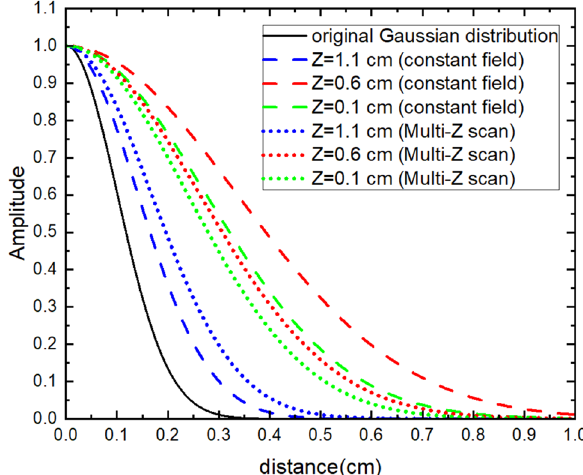
Figure 8. Fitting curve of the normal distribution of the source.